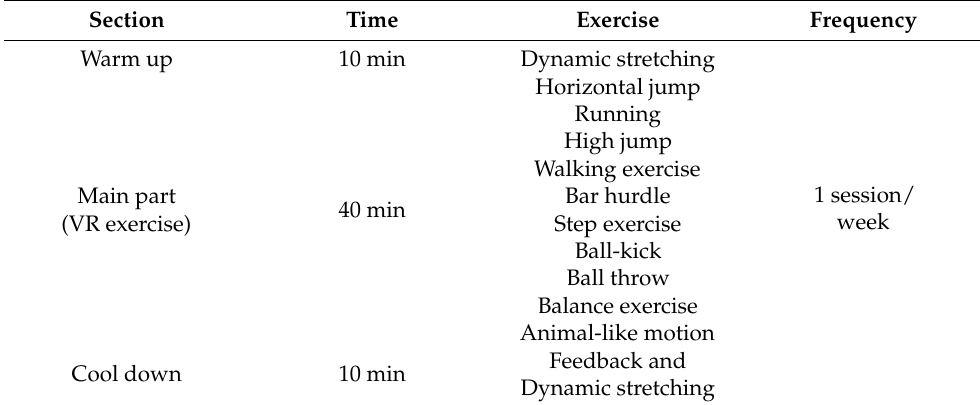
Table 7. VR exercise program.